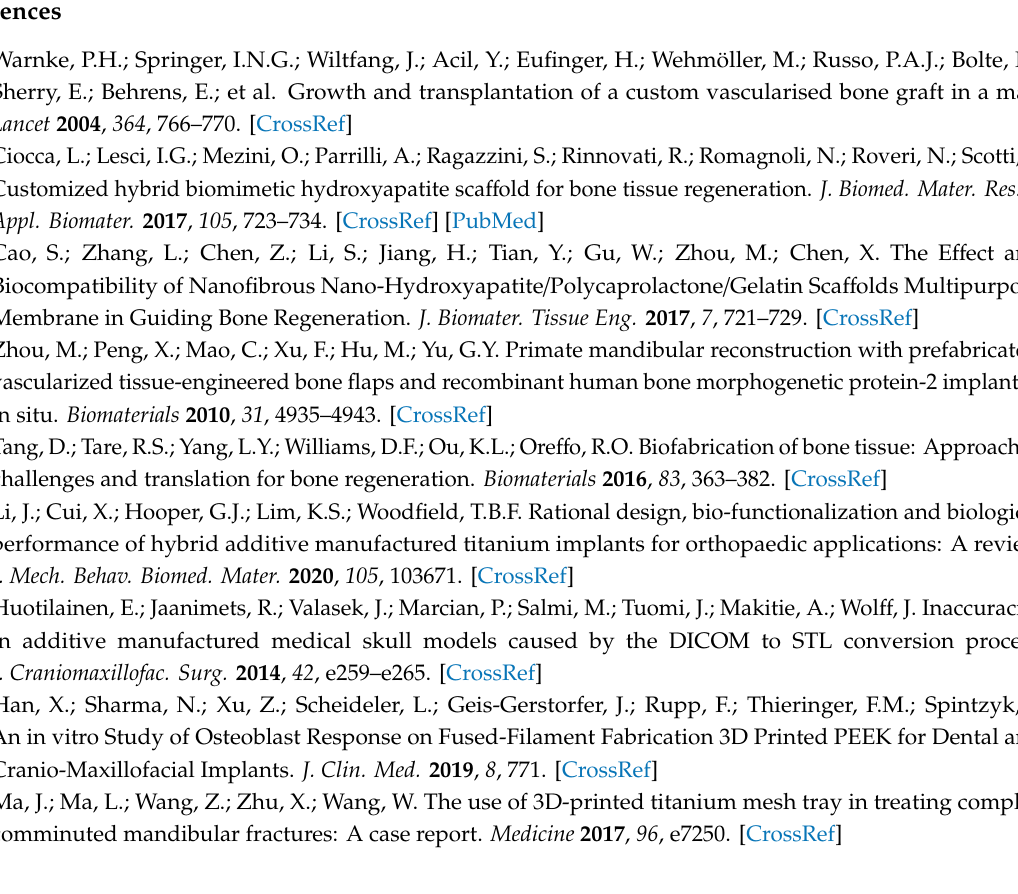
Figure S1: Protein concentration of C-TCP, 3D-PLGA / TCP, and 3D-TCP sca ff olds. (a) Standard curve of bovine serum albumin (BSA) protein. (b) BSA protein staining for calculating standard curve. (c) Quantified protein concentration of C-TCP, 3D-PLGA / TCP, and 3D-TCP sca ff olds on day 3, 7, and